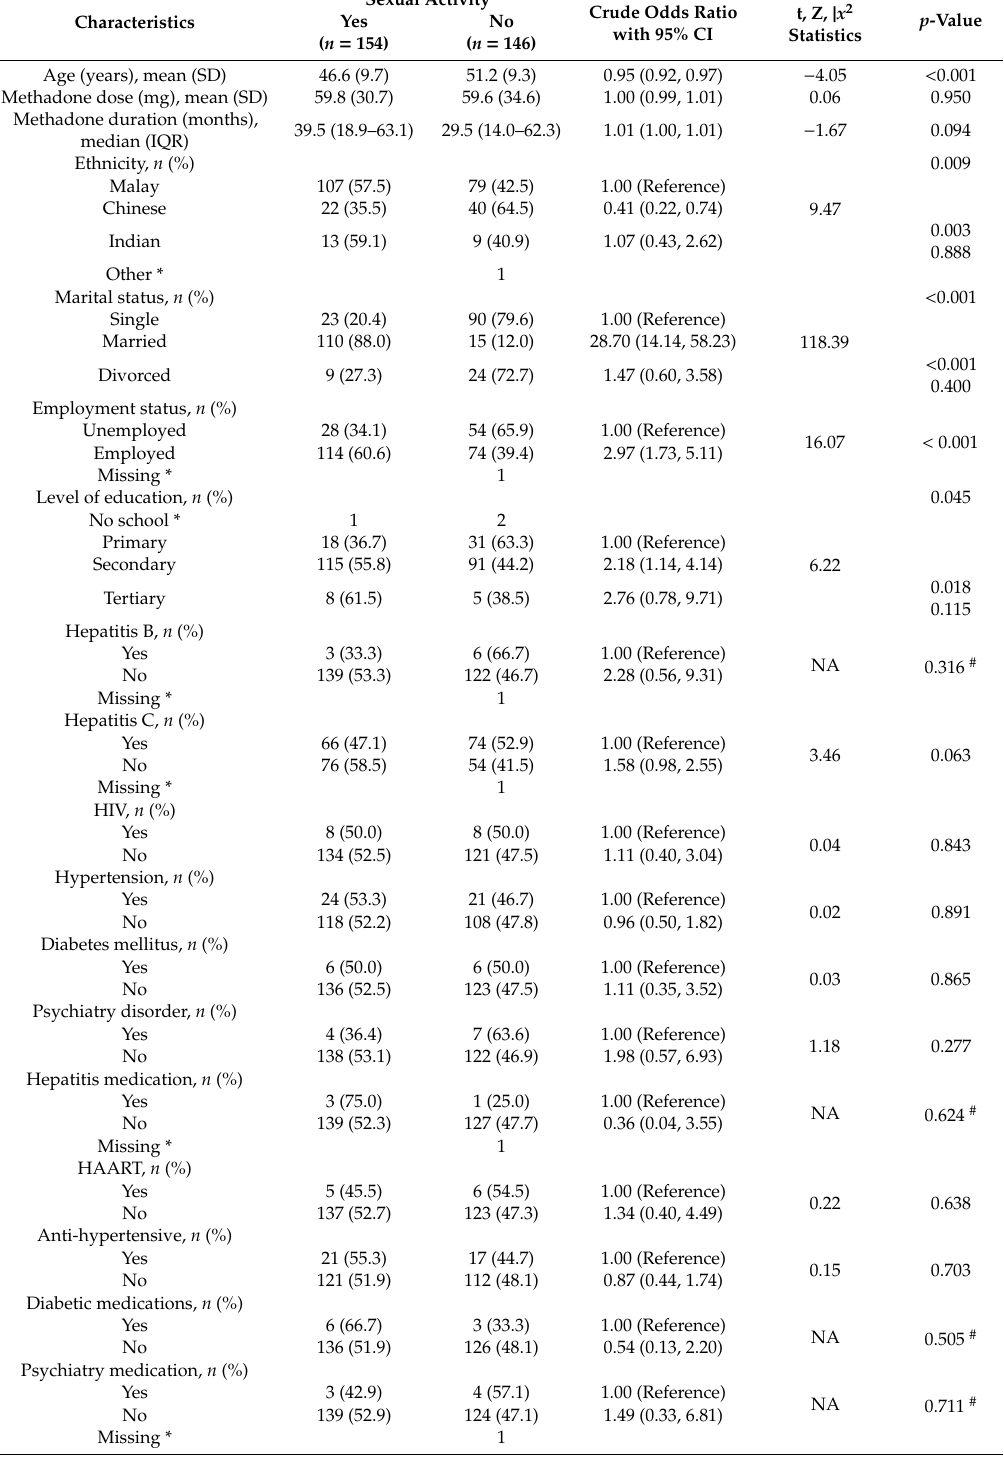
Table 2. Bivariate analysis of the associations between sociodemographic, methadone treatment (dose and duration), and clinical variables with sexual activity among patients on methadone maintenance treatment (MMT) ( n =